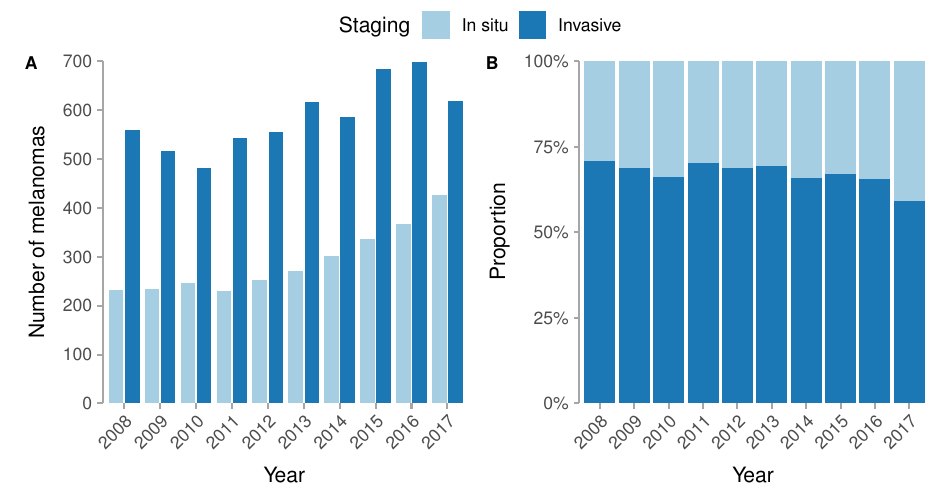
Figure 1. Distribution of invasive and in situ